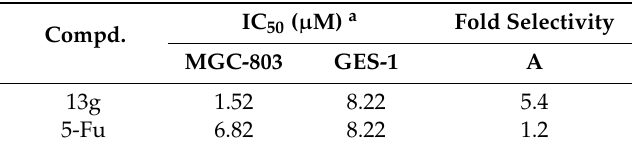
Table 2. In vitro anti-proliferative activity of 13e against gastric cancer cells (MGC-803) and non-cancer cell lines (GES-1).